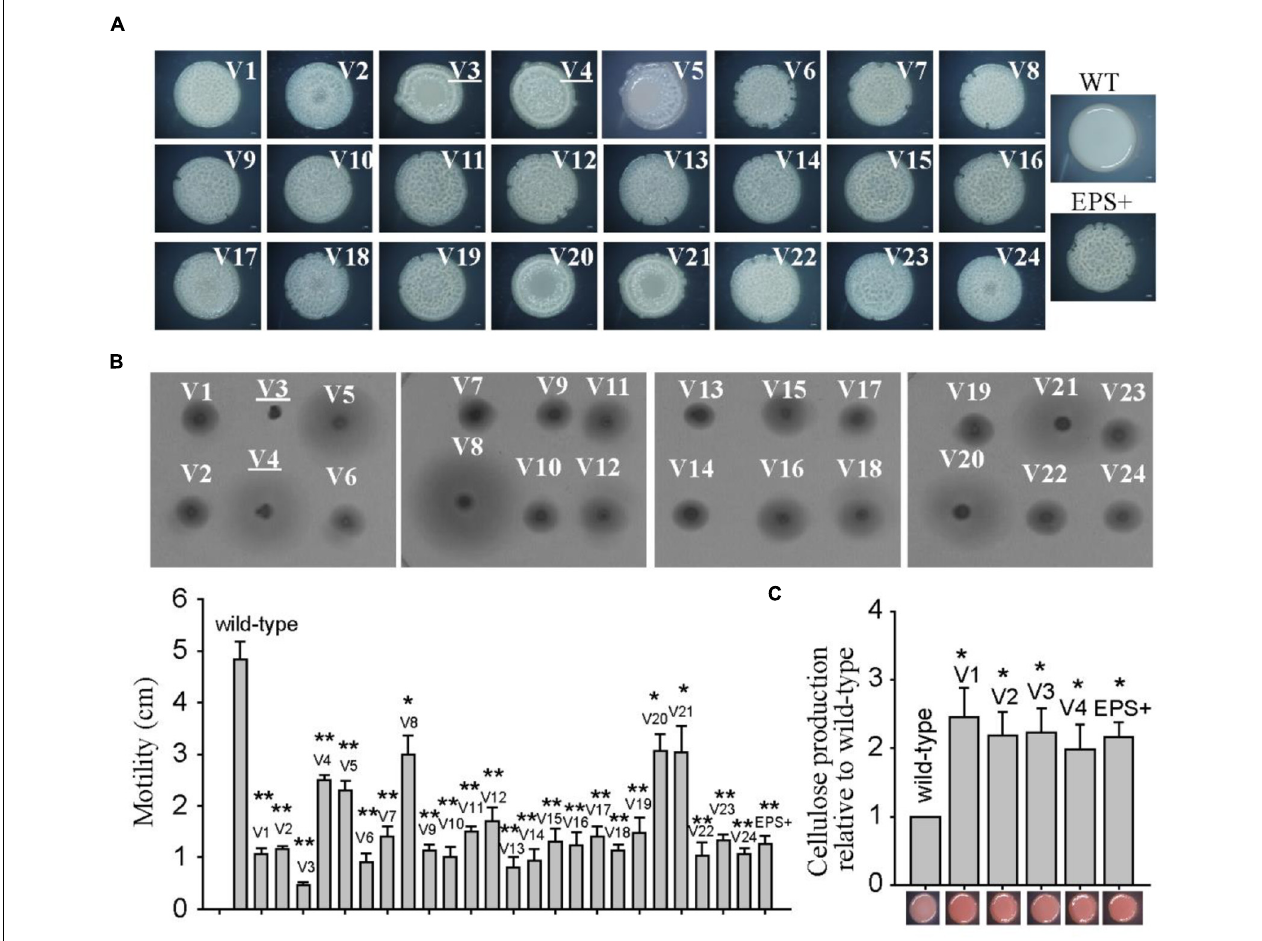
FIGURE 1 | The wrinkled variant reduced swimming motility while increasing cellulose production. (A) The colony morphologies of twenty-four wrinkled variants were examined by stereoscopic microscopy after 3 days of incubation on SWLB agar plates. The colony morphologies of wild-type P. lipolytica and the EPS+ strain, a wrinkled variant, are also presented. (B) Swimming motility of the wrinkled variants was examined and measured by culturing on semisolid 2216E agar plates for 20 h. (C) Cellulose production was examined and measured using Congo red for the wild-type and different wrinkled variants (representative V1 to V4 and EPS+ strains were shown). The data are from three independent cultures. Standard deviations are shown, and statistical significance (* P < 0.05; ** P < 0.01; NS, not significant) is indicated with asterisks. Images shown in Figures 1 – 5 are representative